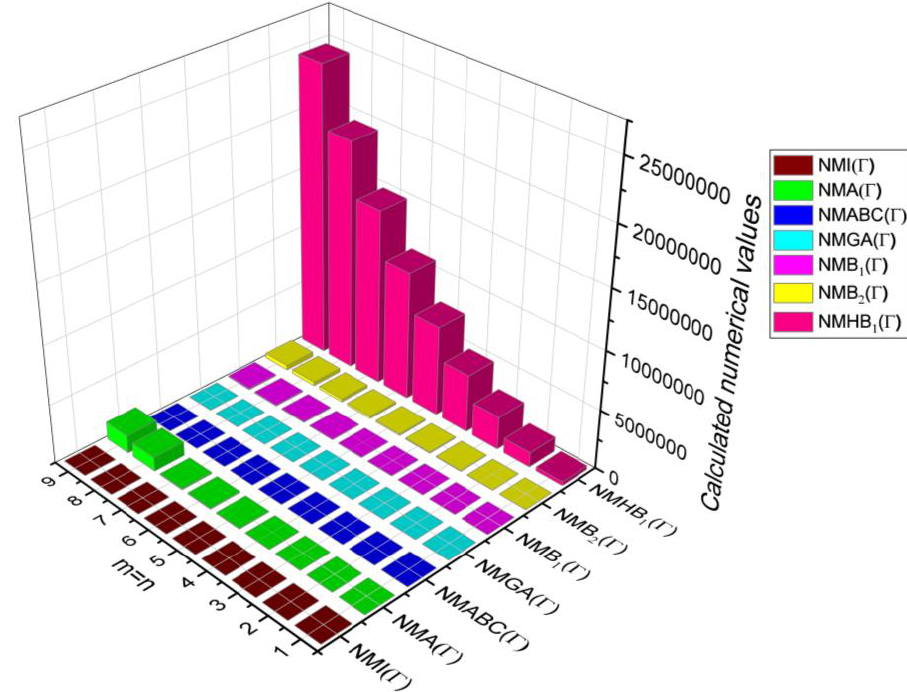
Figure 10. 3D plots for Table 9. Table 8. Comparison Table for Theorem 5.